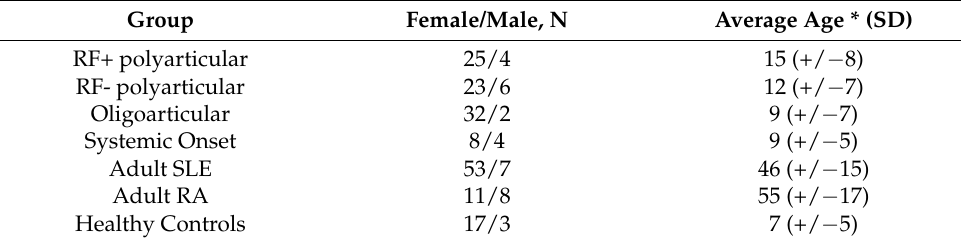
Table 1. Demographic data by patient